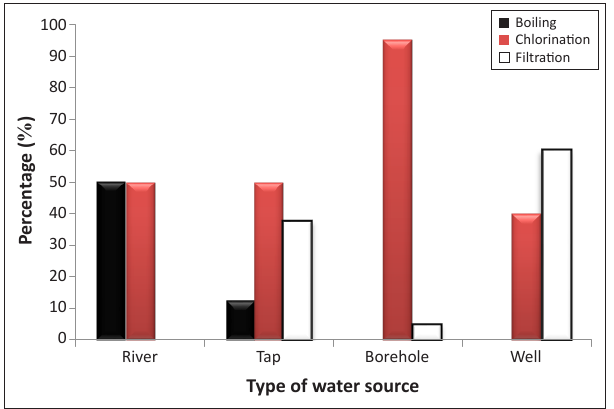
FIGURE 2 : Types of water sources and the preferred water treatment methods used by